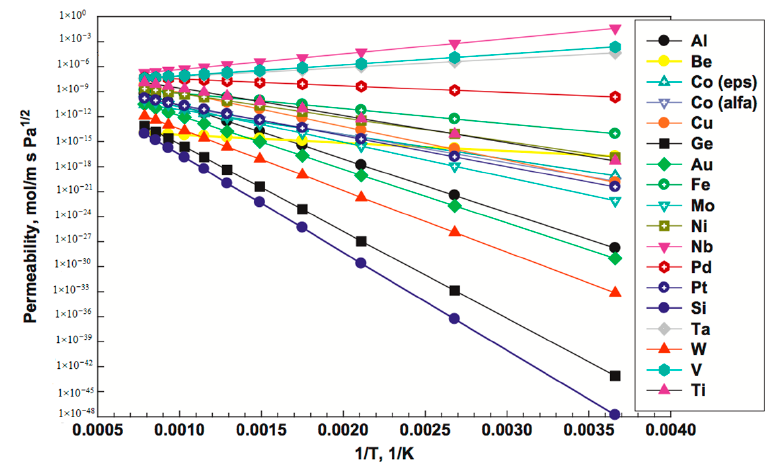
Figure 9. Hydrogen permeability as a function of temperature for different interesting metals. Reprinted from [172] with permission from Elsevier.